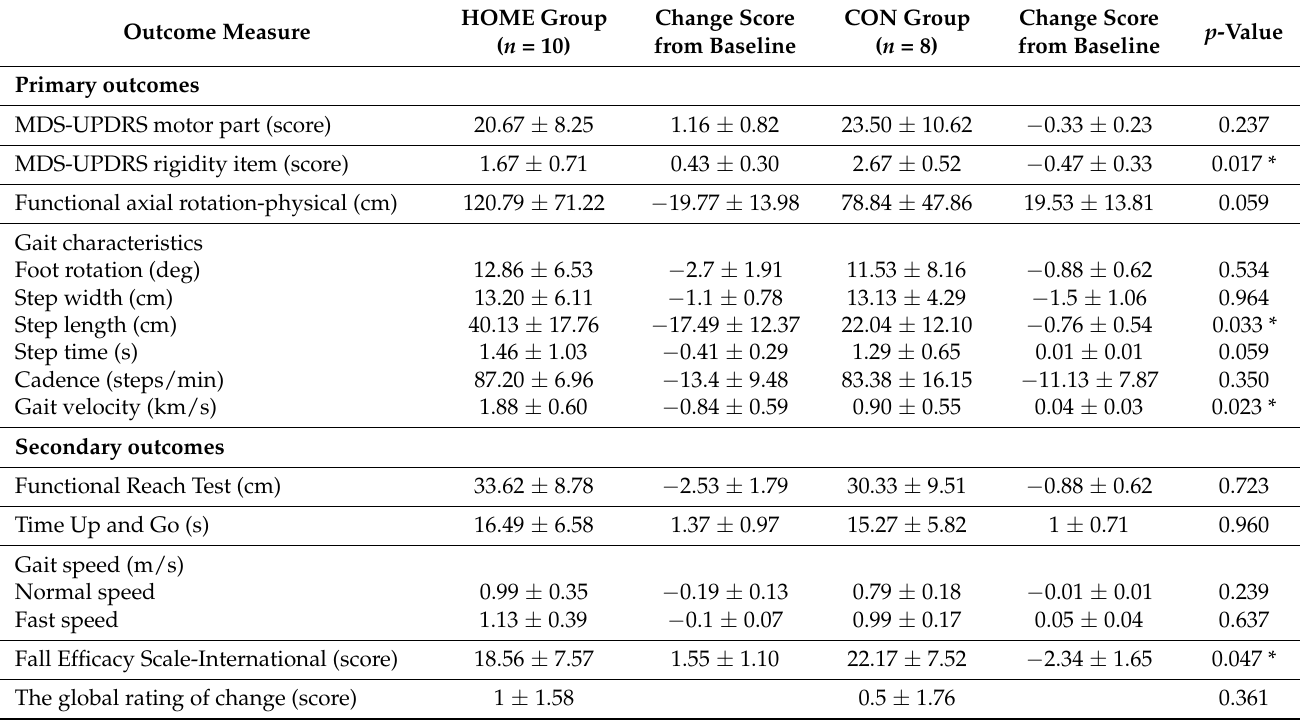
Table 3. Comparison of primary and secondary outcomes and the changes between groups. Values are mean ± standard deviation.